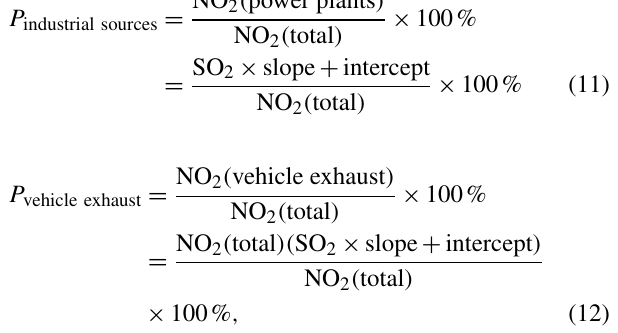
Figure 10. Scatter plot of NO 2 and SO 2 VCD data around power plants along the Yangtze River. NO 2 and SO 2 VCDs measured within 2km of the power plants are used for the